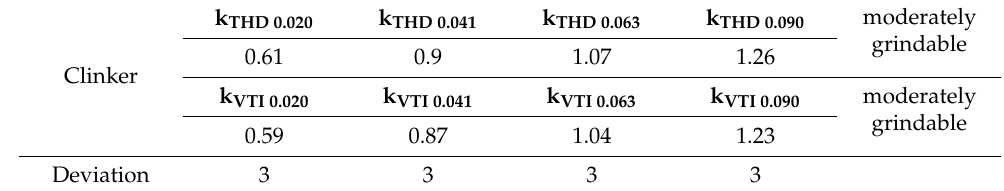
Table 18. Comparison of grindability indexes k THD and k VTI (-) and classification of clinker.